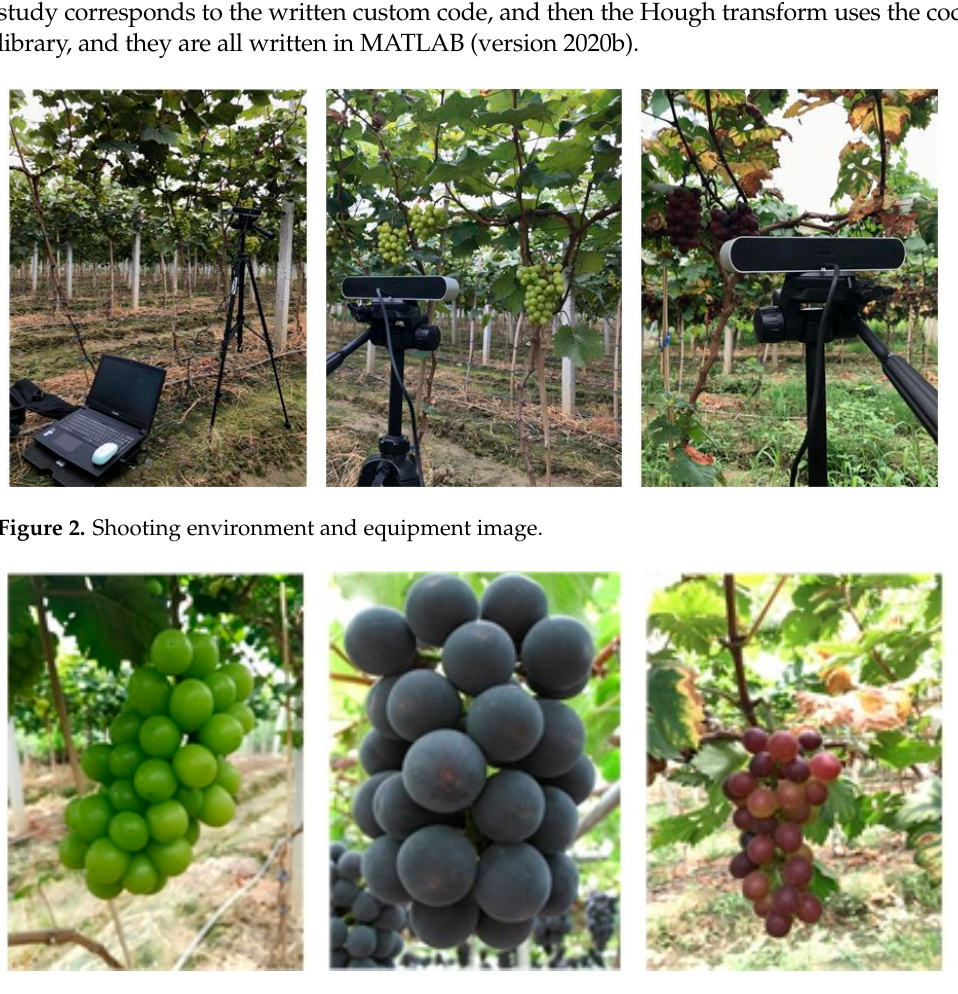
Figure 3. The image of grape strings of various types. A single grape is obtained after removing the background through the perfect back- ground removal algorithm. To reduce interference effects such as noise on the grape berries, this paper uses bilateral filtering to remove the interference in the image while retaining the edge information. The filtered RGB image is converted into a gray image; examples are shown in Figure 4b. According to the user-defined threshold and standard deviation, Canny edge detection model is applied to the gray image to extract the edge information of grape berries. The final effect is shown in Figure